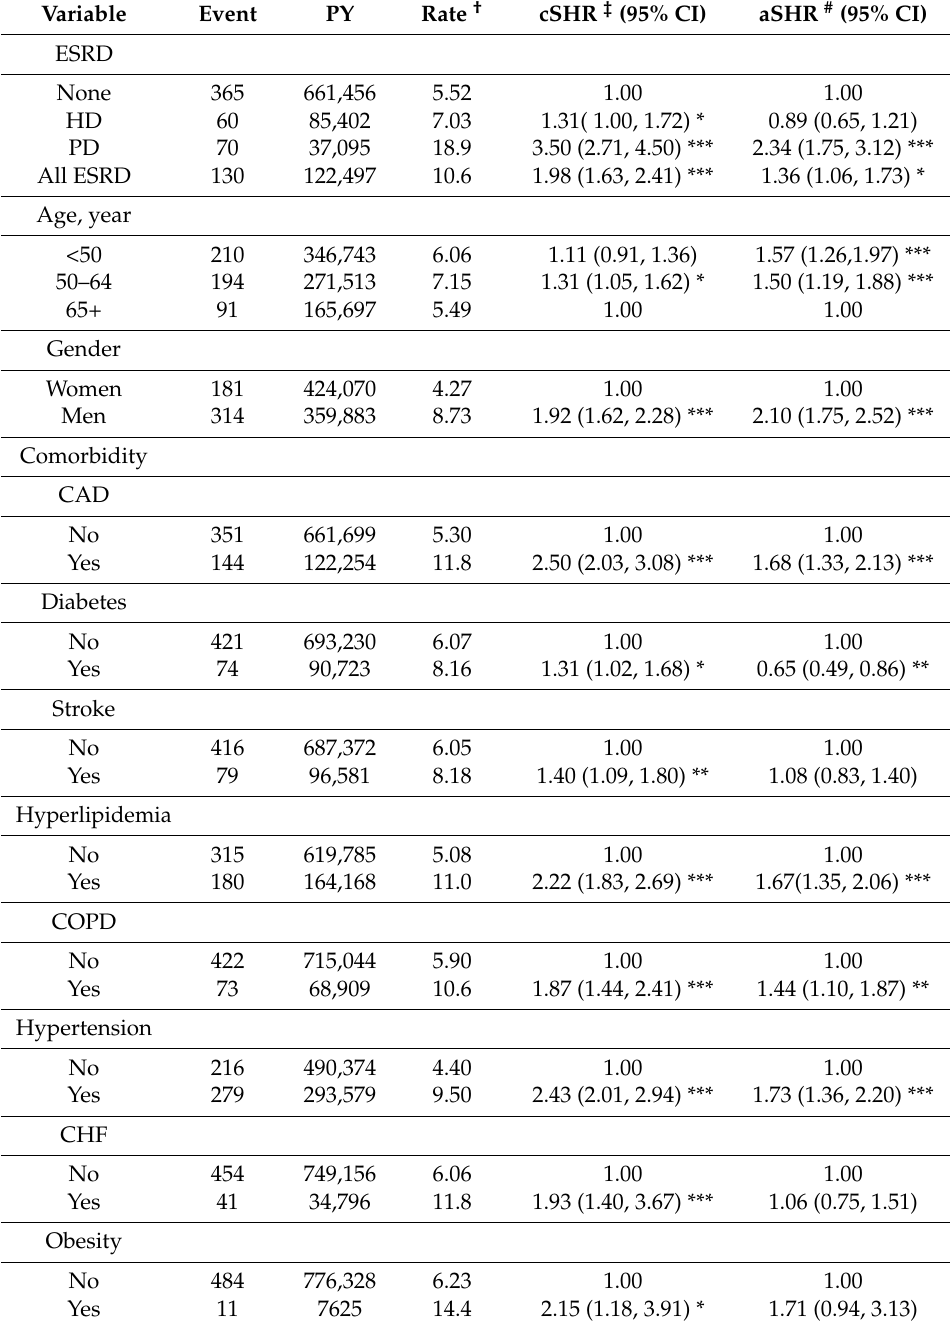
Table 2. The incidence (per 10,000 person-years) and HR for OSA and OSA-associated risk factor in competing risks regression analyses in the age and sex frequency matched